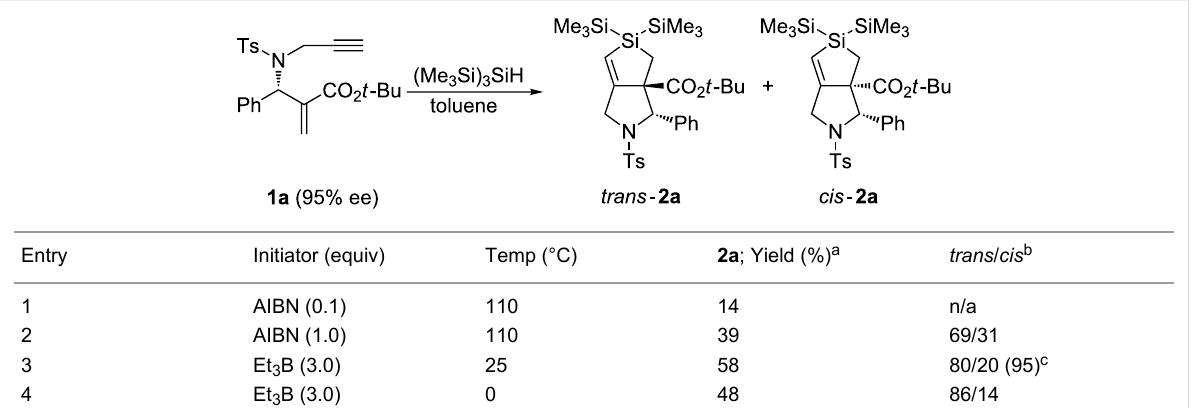
Table 1: Radical cascade reaction under various reaction